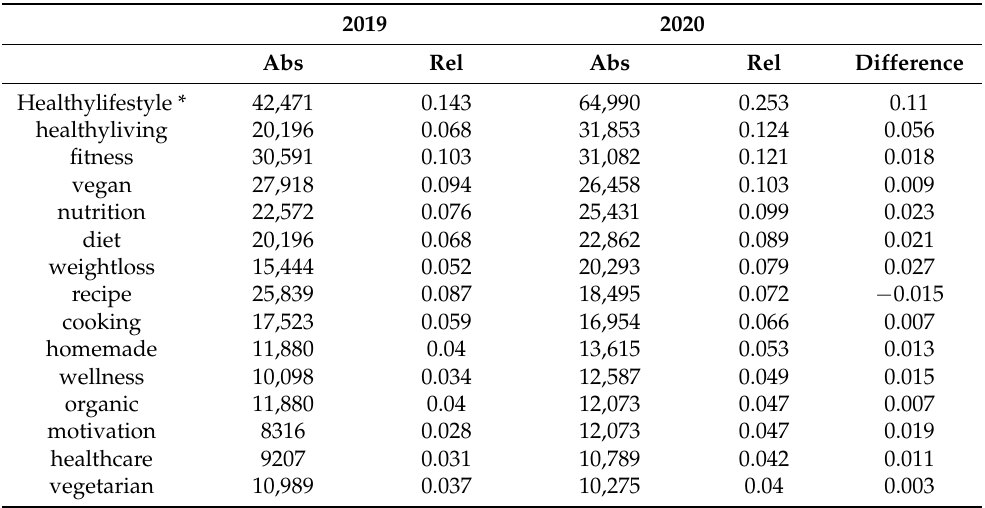
Table 1. Hashtags published in connection with the hashtag #healthyfood in 2019 and